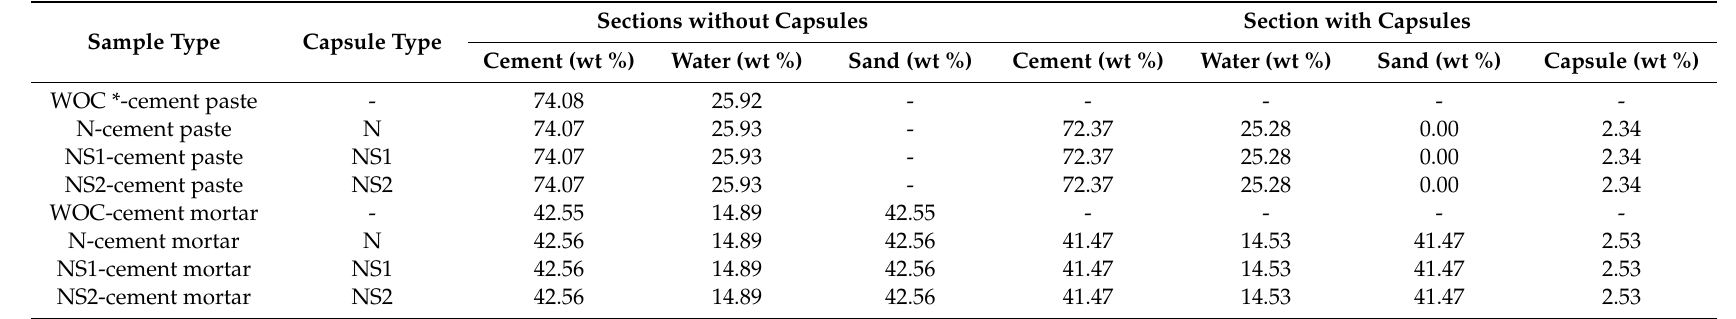
Table 2. Summary of the cement paste and